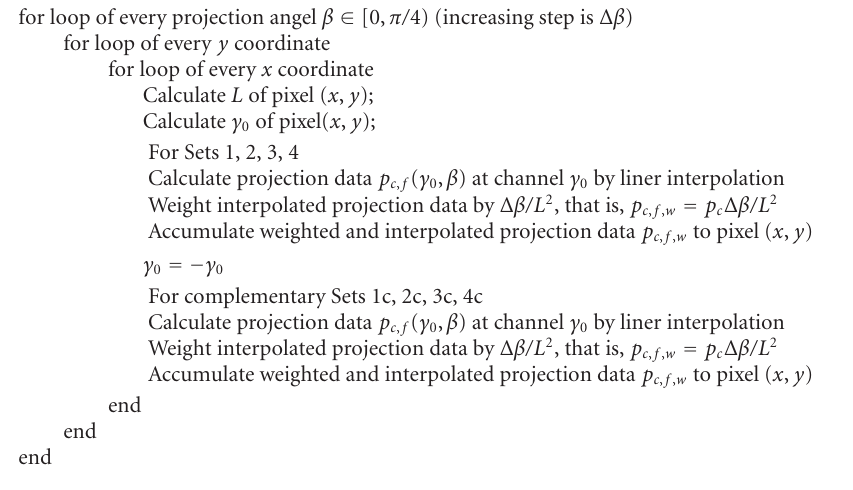
Algorithm 2: Pseudocode for the backprojection with the right-angle and complement symmetries.